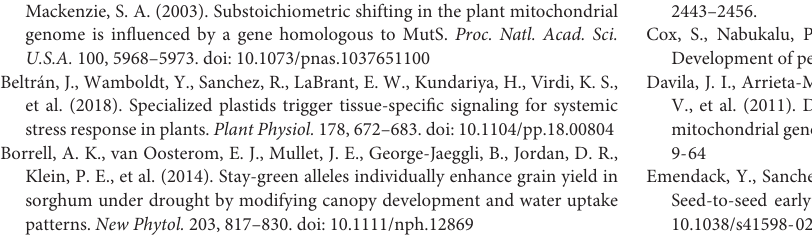
Supplementary Figure 7 | Field cold stress germination experiment. 150 epi-F3 and 19 wild type lines were tested in the field for germination rate under cold stress conditions, with early planting at the Havelock site on April 20 (Experiment 1) and April 16 (Experiment 2). Planting day soil temperature at 10 cm depth was